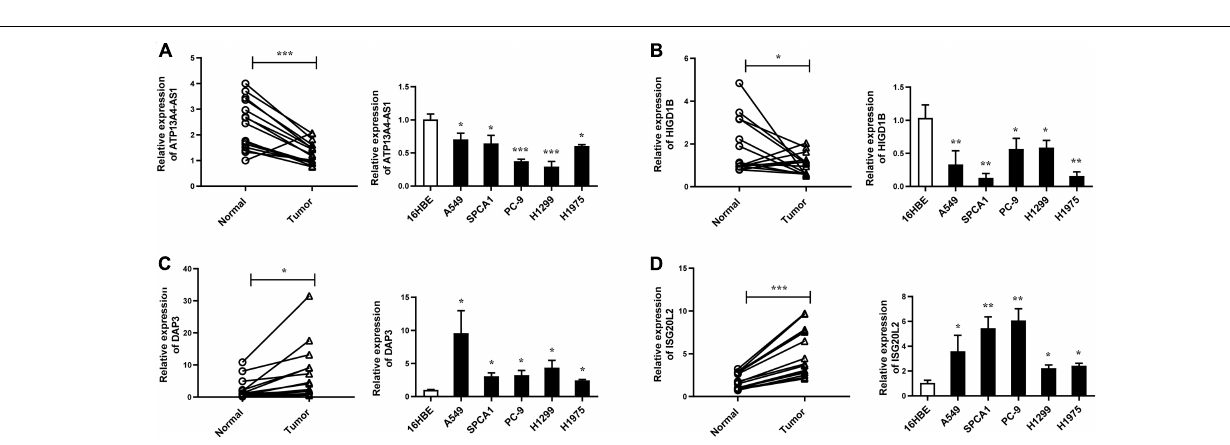
FIGURE 7 | The expression levels of ATP13A4-AS1 (A) , HIGD1B (B) , DAP3 (C) , and ISG20L2 (D) in LUAD tissues and cell lines detected by RT-qPCR. Human bronchial epithelial cell line: 16BE. LUAD cell lines: A549, SPCA1, PC9, H1299, and H1975. Data were means ± SEM. ∗ P < 0.05, ∗∗ P < 0.01, ∗∗∗ P < 0.001. Experiments were repeated three